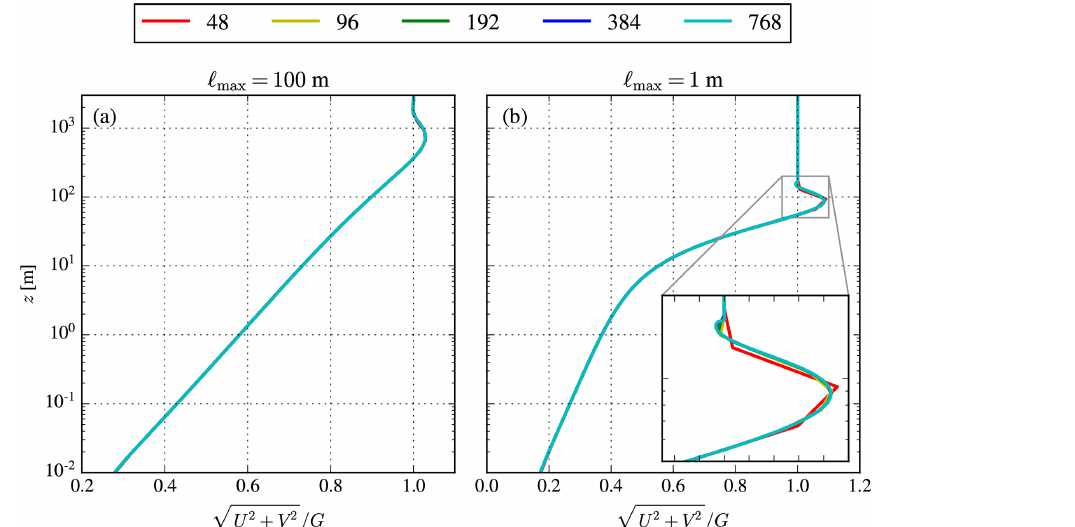
Figure 2. Grid refinement study of the one-dimensional RANS simulation using the limited-length-scale k – ε model, for 48, 96, 192, 384, and 768 cells. (a) (cid:96) max = 100m. (b) (cid:96) max = 1m.